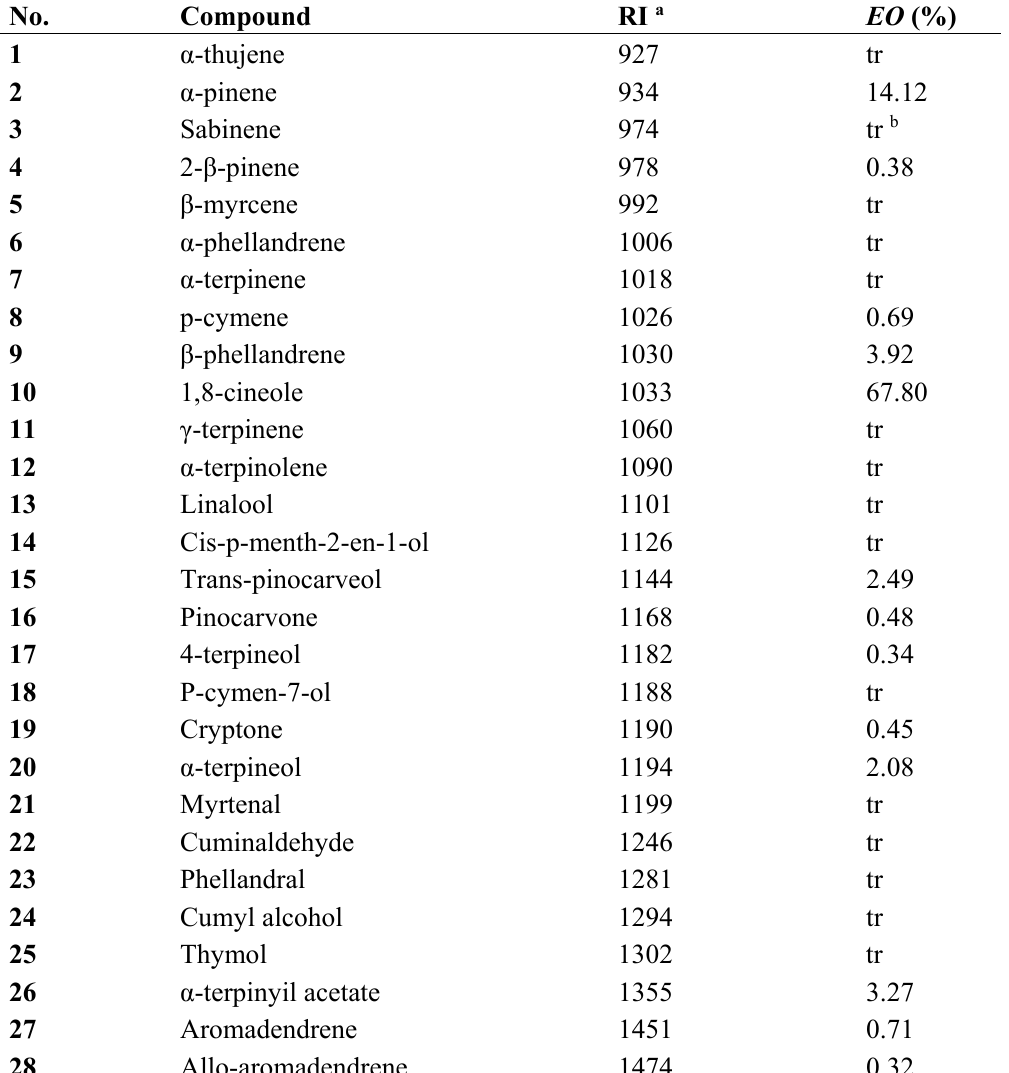
Table 1. Chemical composition (%) of essential oil of E.